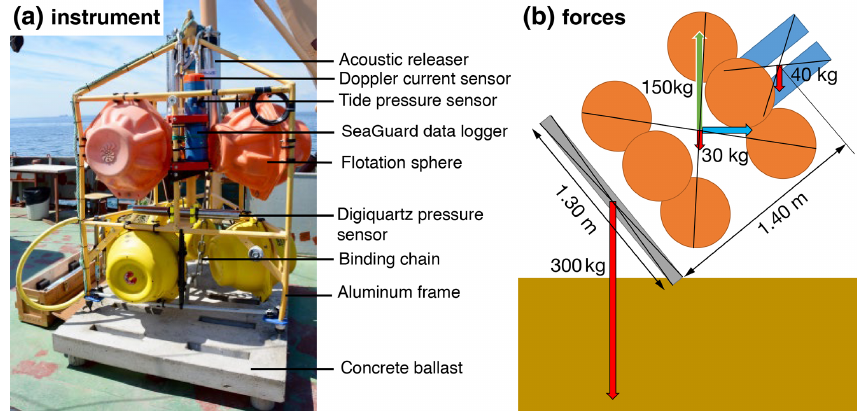
Figure 2. Instrumented frame. (a) Photo of the instrumented frame before deployment. (b) Sketch showing forces applied to the elements of the instrumented frame in water. The red arrows represent the weight in water of the cement ballast, of the instrumented frame and of the acoustic release system on top. The green arrow represents the buoyancy of the flotation spheres. The blue arrow represents the current drag, which depends on current speed and instrument